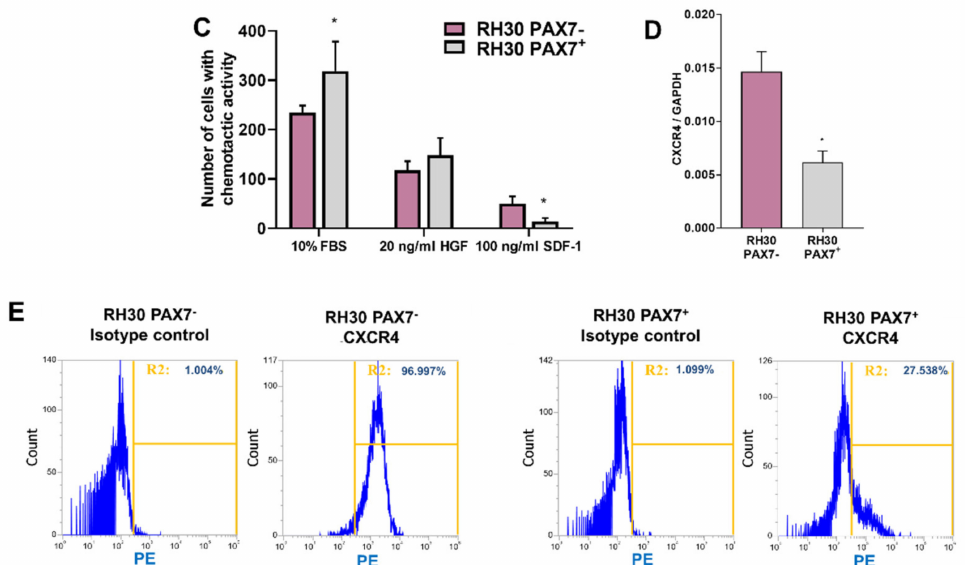
Figure 3. RH30 PAX7 − and PAX7 + subclones differed in migratory and chemotactic capabilities. ( A ) RH30 PAX7 − cells migrated faster in a scratch assay. Representative images of scratch assay are shown at time 0 and after 24 h from the same locations. Scale bar represents 500 µ m. ( B ) RH30 PAX7 − cells displayed faster scratch reduction, n = 4. ( C ) RH30 PAX7 − cells had lower number of cells with chemotactic ability towards 10% FBS and higher towards 100 ng/mL SDF-1. No differences were shown between RH30 PAX7 − and RH30 PAX7 + in chemotactic ability towards 20 ng/mL HGF; n = 3. ( D ) RH30 PAX7 − cells displayed higher CXCR4 mRNA expression levels evaluated with qPCR. Data were calculated with 2 − ∆ Ct method using GAPDH as a constitutive gene, n = 3. ( E ) RH30 PAX7 − cells displayed higher level of CXCR4 receptor evaluated with flow cytometry. Representative images are shown. The data on graphs show means ± SEM. * p <